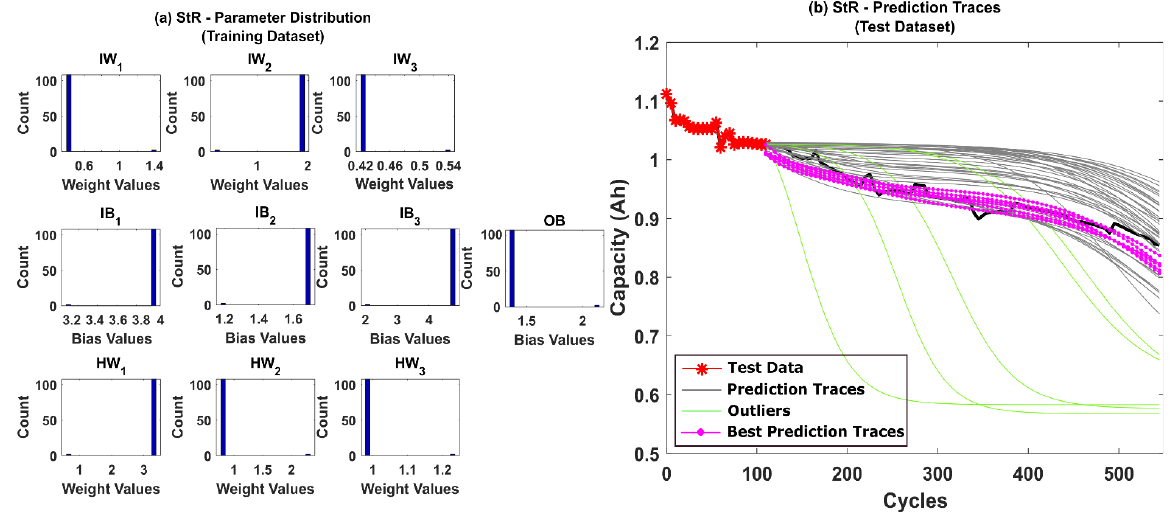
Figure 7. ( a ) The posterior distribution of MLP network parameters estimated by the adaptive Bayesian learning framework using StR and ( b ) the degradation prediction traces for CALCE battery (CS-37) using StR. The prediction traces for 50 repetitions are shown using the gray lines, the green lines represent outliers, and the magenta lines represent the traces with minimum RMSE values.